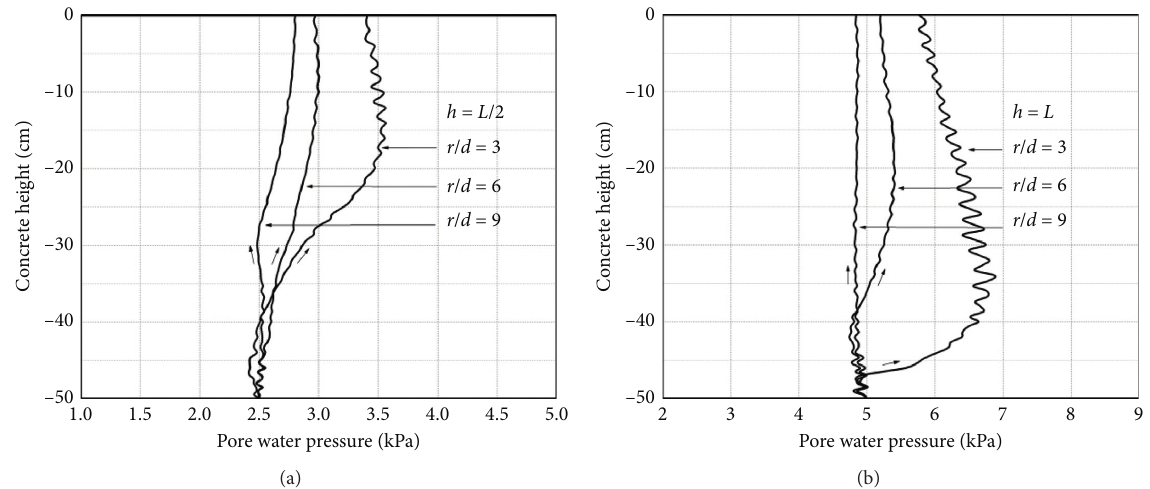
Figure 10: The pore water pressure at the middle and bottom of the pile varies with the concrete height during concrete pouring